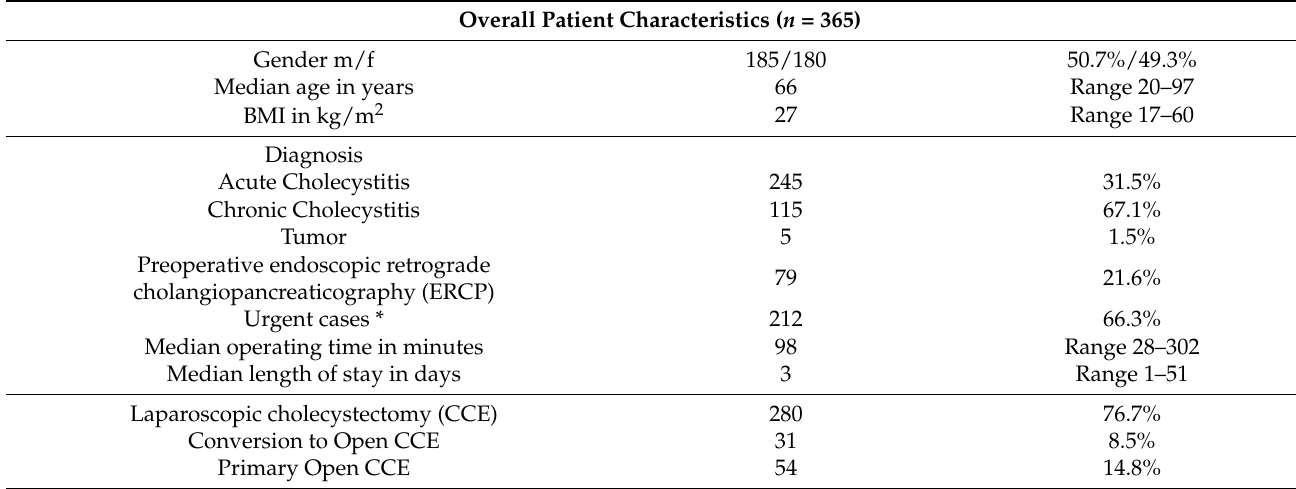
Table 1. The characteristics of all patients that had specimens sent for microbiological culture. * Urgent cases were defined as all patients that had to undergo cholecystectomy within 72 h of symptom